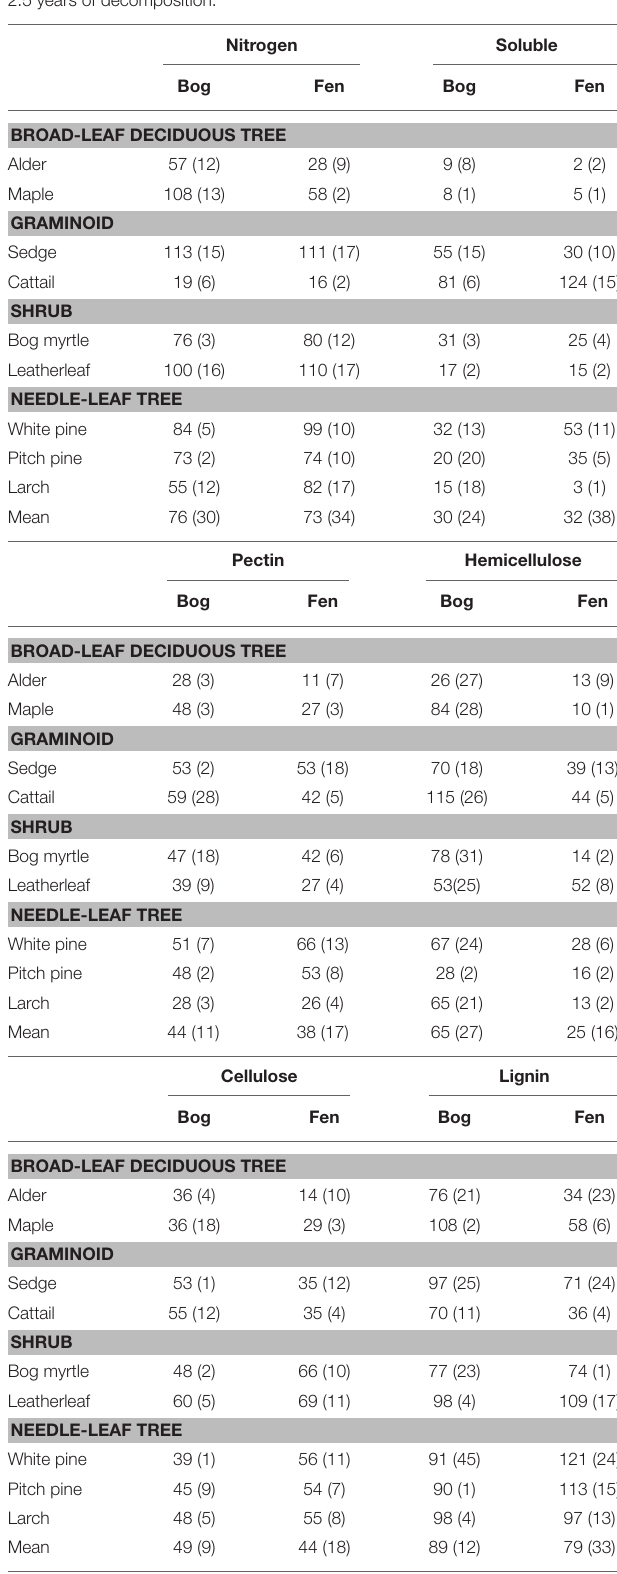
TABLE 4 | Fraction remaining (%) of original mass of cell wall components after 2.5 years of decomposition.